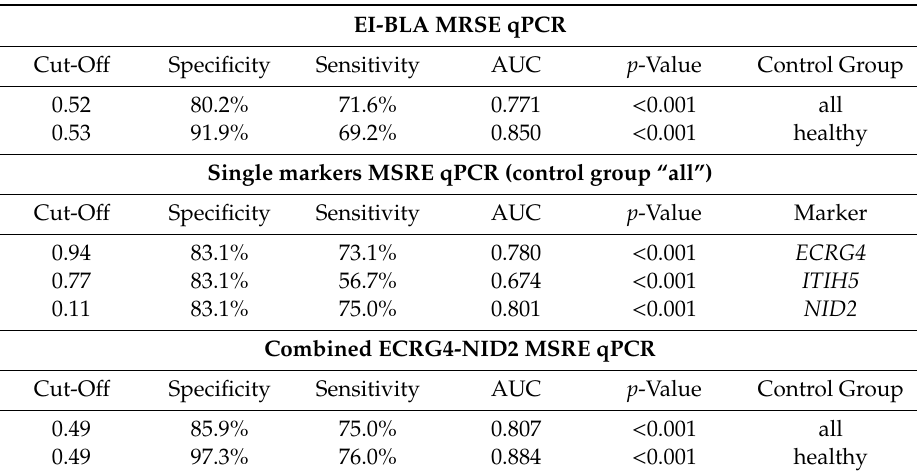
Table 4. Biomarker performances based on training cohort